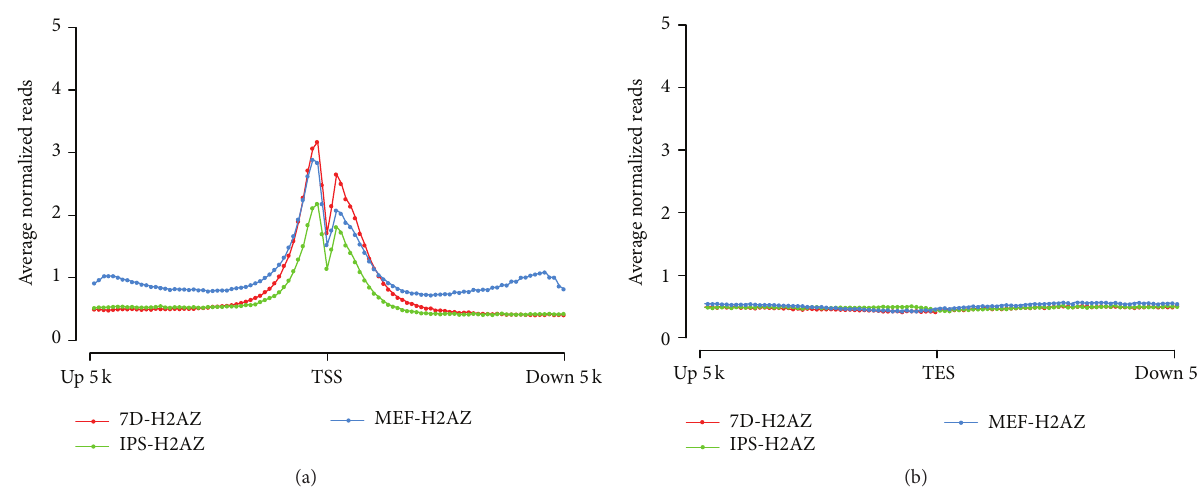
Figure 2: The distribution of average normalized reads in TSS and TES gene regions. The regions 5 kb upstream and downstream the TSS (a) and TES (b) are divided into 40 windows, and H2A.Z average normalized reads coverage is assessed in each window.